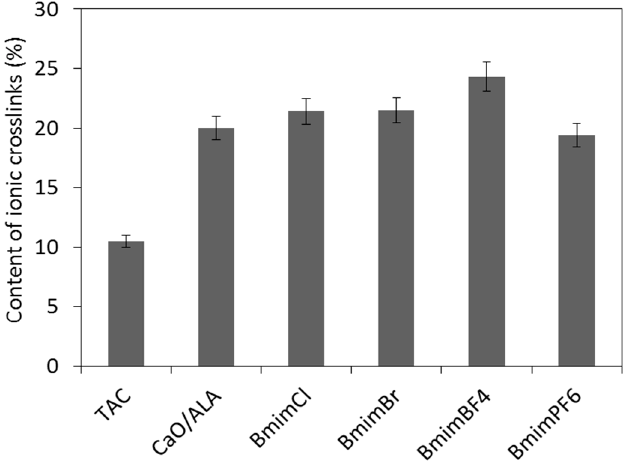
Figure 7. Content of non-covalent crosslinks in silica-filled EPM vulcanizates.